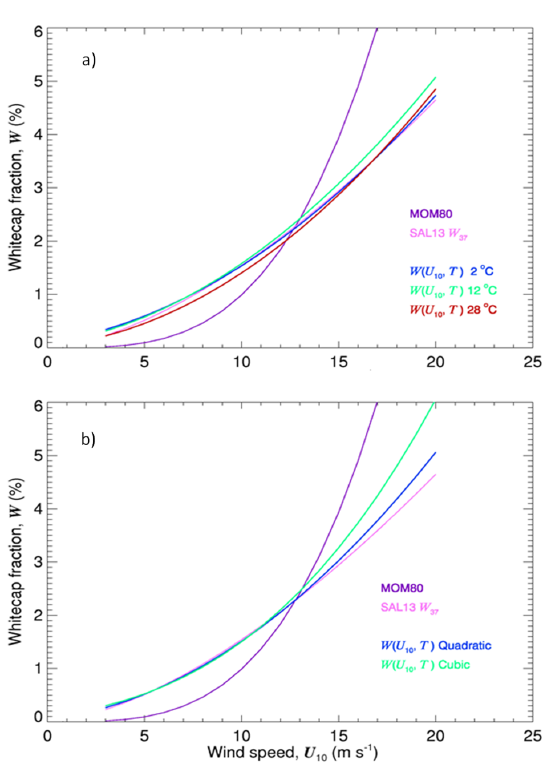
Figure 13. (a) Comparison of the new parameterization W(U 10 ,T ) (Eqs. 13–14) at three fixed SST values ( T = 28 ◦ C, red line; T = 12 ◦ C, green line; T = 2 ◦ C, blue line) to the parameterizations of Salisbury et al. (2013, SAL13) (Eq. 1) for 37GHz (magenta line) and Monahan and O’Muircheartaigh (1980, MOM80) (Eq. 3) (pur- ple line). (b) Comparison of the new W(U 10 ,T ) parameterizations with quadratic (Eqs. 13–14, blue line) and cubic (green line) wind speed exponents at T = 20 ◦ C to the parameterizations of SAL13 for 37GHz (magenta line) and MOM80 (purple